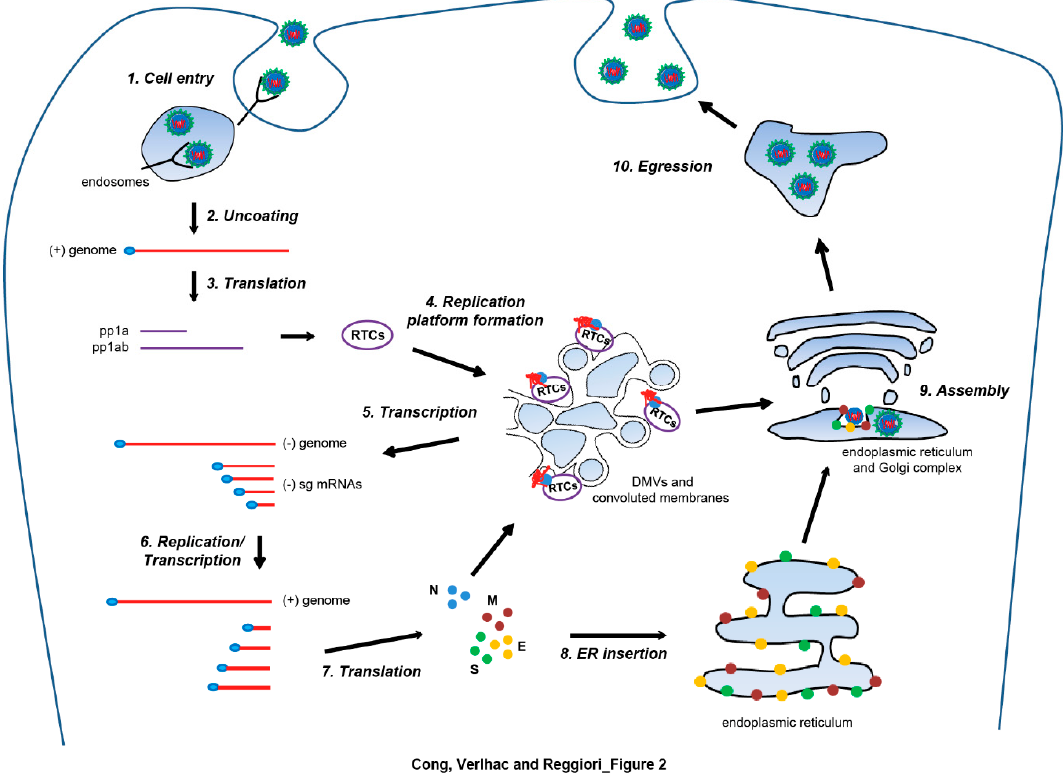
Figure 2. Generalization of Nidovirales life cycle, based on the information acquired studying Arteriviruses and Coronaviruses . Infection starts with the binding of the viral particle to a cell surface receptor and subsequent cell entry through membrane fusion in endosomes upon endocytosis